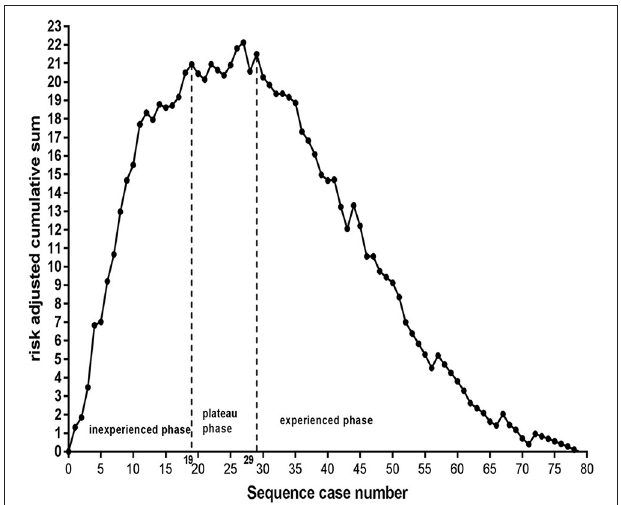
FIGURE 3 | Inexperience phase: from the 1st to the 19th case, plateaus phase: from the 19th to 29th case, experience phase: after the 29th case. The threshold required to achieve successful reperfusion is 29 cases. TABLE 3 | Comparison between the results of our study after experience with 29 cases and the published data from the HERMES collaboration. Our study ( N = 231)